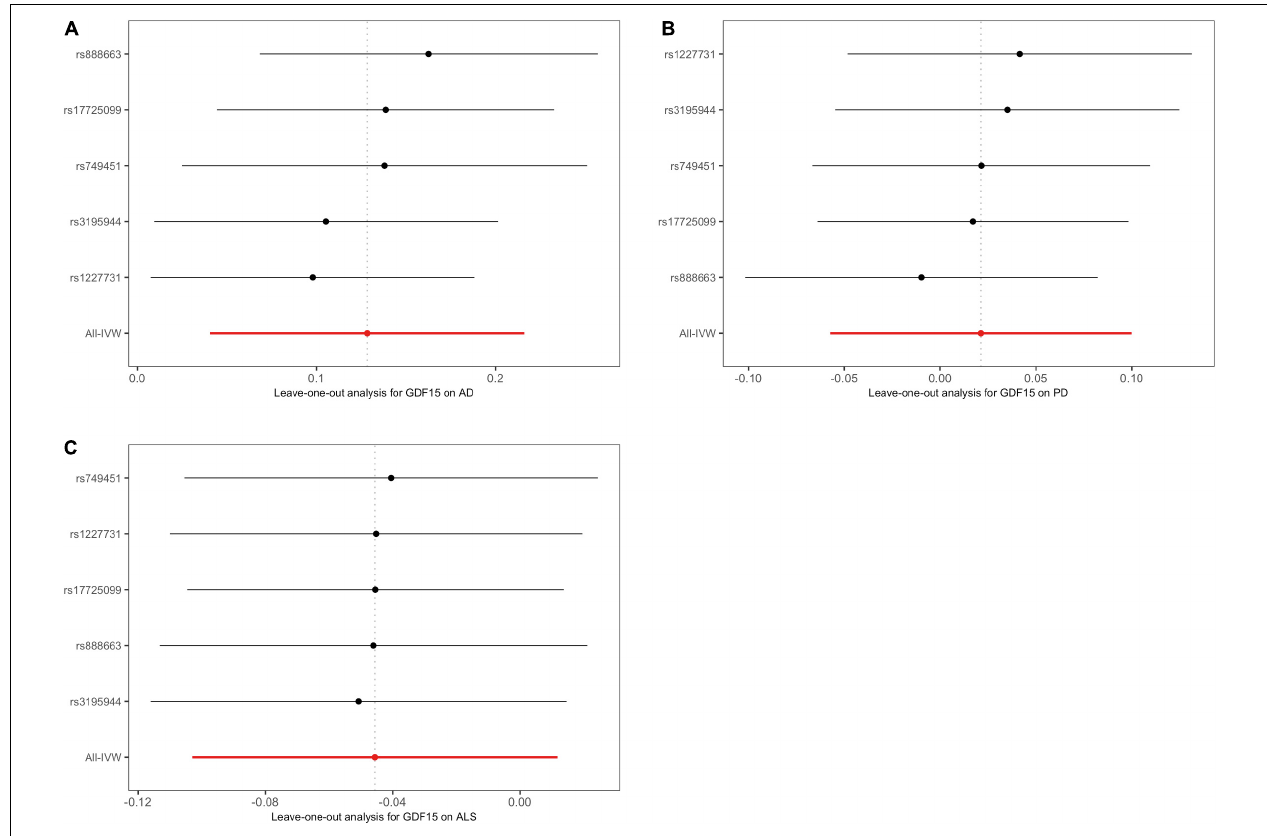
FIGURE 4 | Leave-one-out plots in the Mendelian randomization sensitivity analyses of GDF-15 on three neurodegenerative diseases. There was no evidence of obvious heterogeneity, indicating that no specific SNP alone accounted for the association of GDF-15 with Alzheimer’s disease (A) , Parkinson’s disease (B) , and amyotrophic lateral sclerosis (C) . The IVW causal estimate and how the overall estimate (red horizontal line) was disproportionately driven, which is influenced by the removal of a single variant (black horizontal line), were visualized. AD, Alzheimer’s disease; ALS, amyotrophic lateral sclerosis; GDF-15, growth differentiation factor 15; IVW, inverse-variance weighted model; PD, Parkinson’s